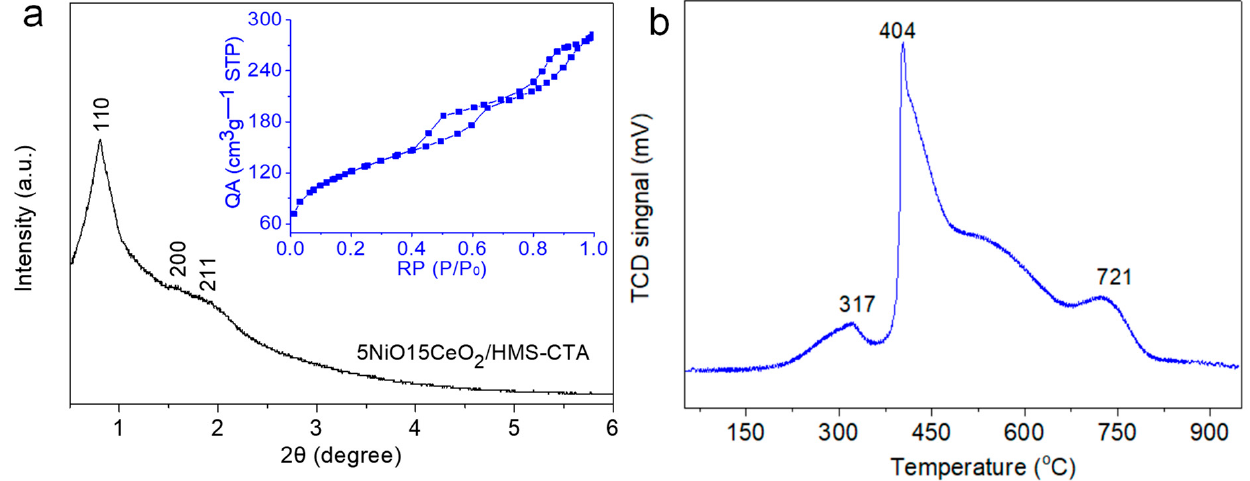
Figure 6. Small-angle XRD pattern ( a ) of the 5NiO15CeO 2 /HMS-CTA catalyst and H 2 -TPR ( b ) Figure 6. Small ‐ angle XRD pattern ( a ) of the 5NiO15CeO 2 /HMS ‐ CTA catalyst and H 2 ‐ TPR ( b ) profile profile of 5NiO15CeO 2 /HMS-CTA sample, the inserted image ( left ) correspond to its nitrogen of 5NiO15CeO 2 /HMS ‐ CTA sample, the inserted image ( left ) correspond to its nitrogen adsorption– adsorption–desorption isotherms desorption isotherms curve.